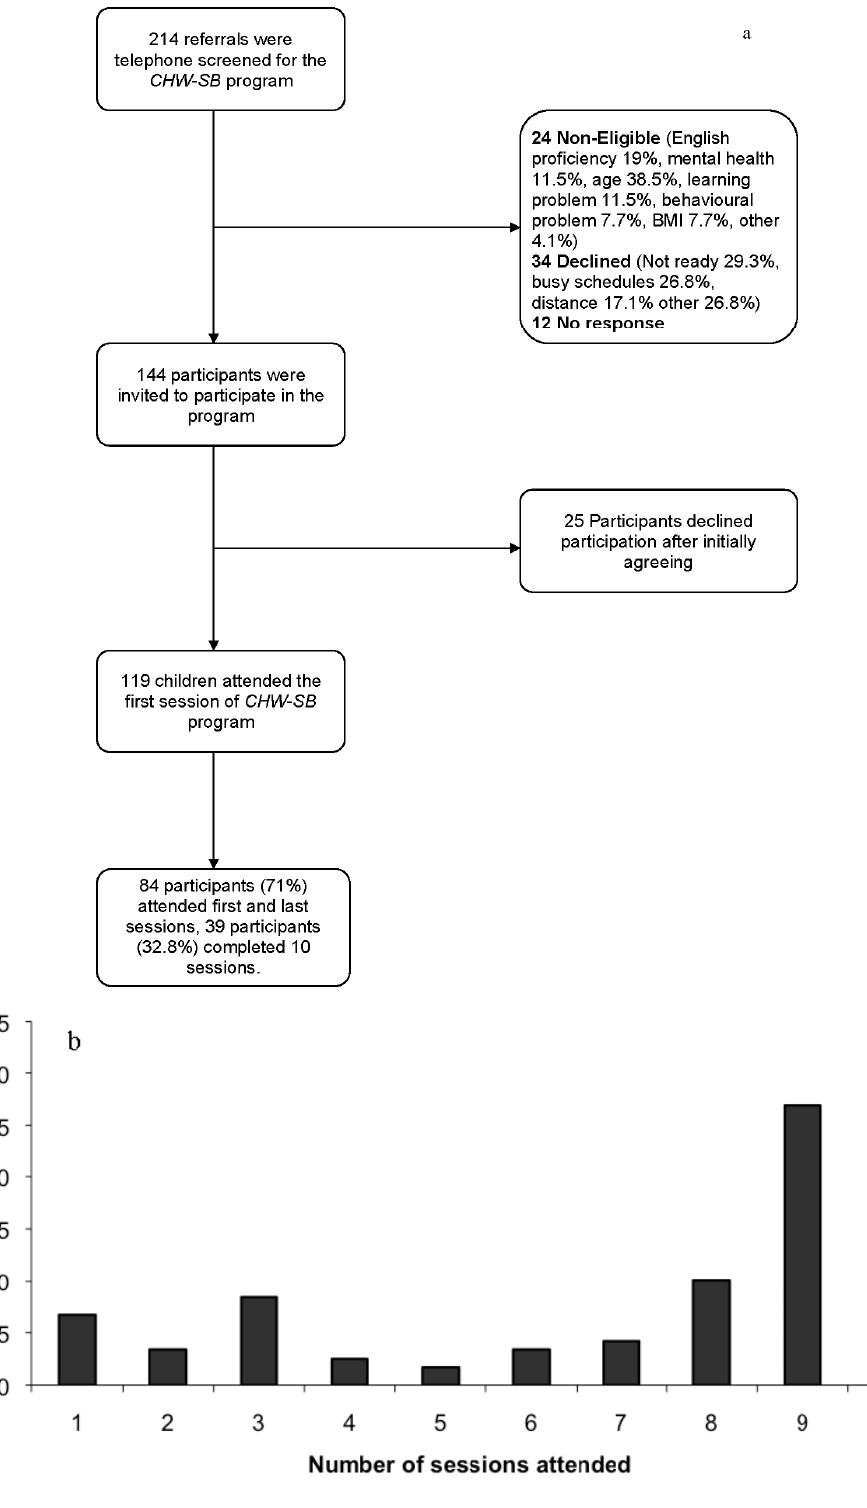
Figure 1. Figure 1 represents the number of sessions that program participants attended. ( a ) Flow Chart of Study Participants, and ( b ) Number of Sessions